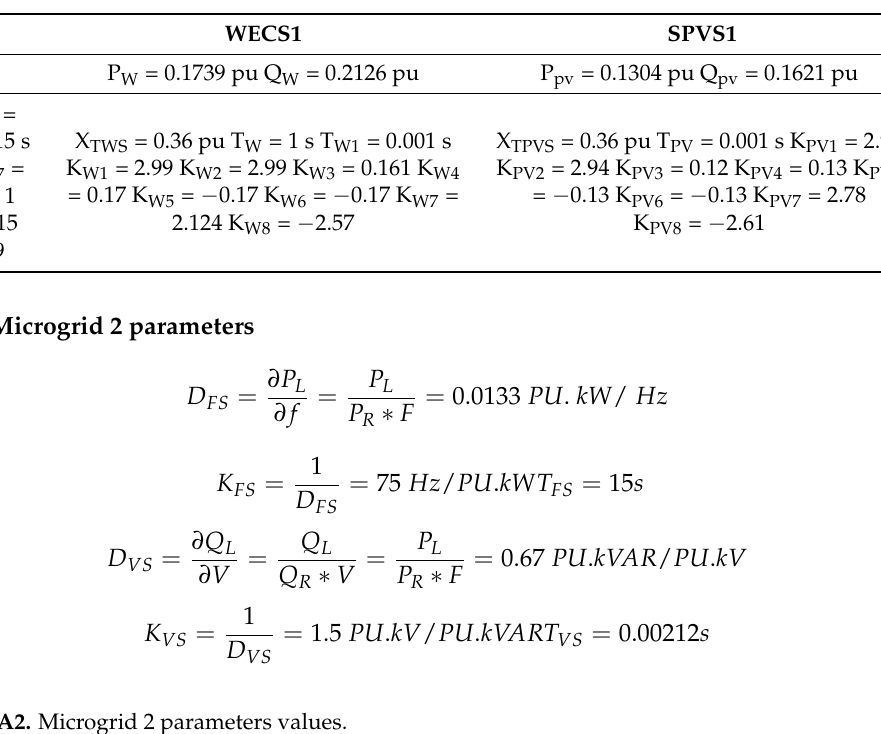
Table A1. Microgrid 1 parameters values.